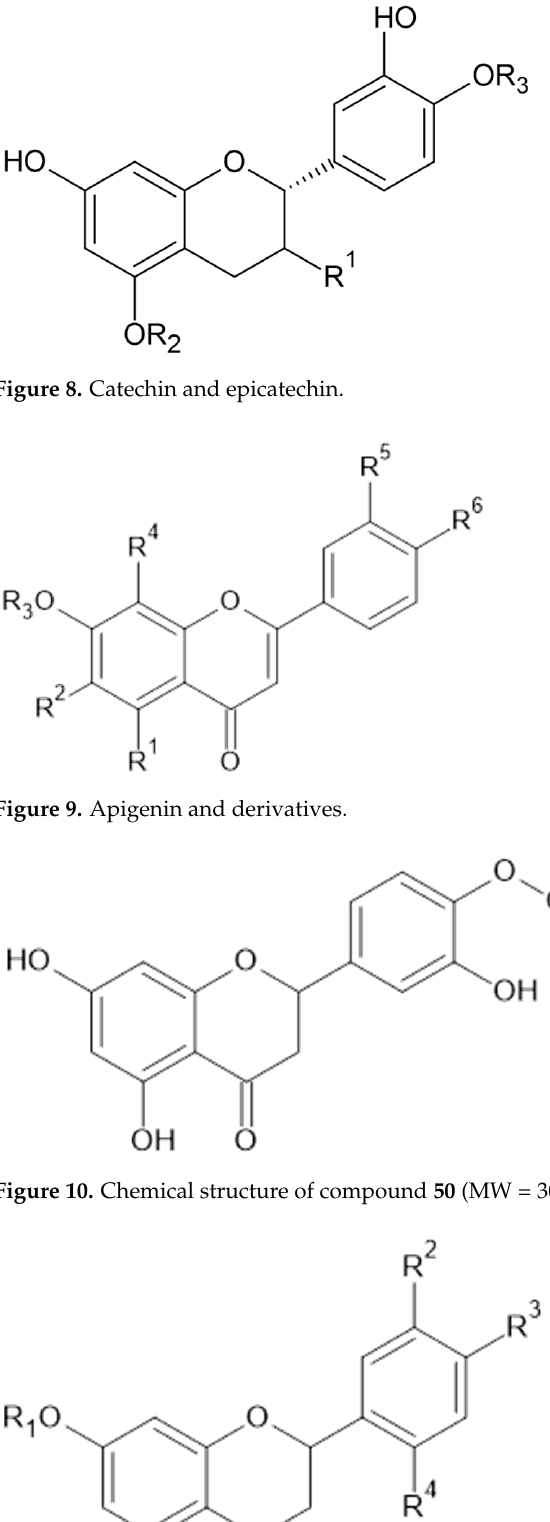
Figure 10. Chemical structure of compound 50 (MW = 302).